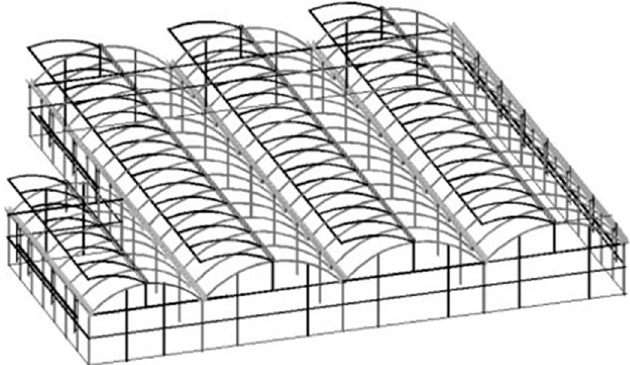
Figure 4. Multi-span or multi-tunnel greenhouse on an irregularly-shaped plot [24].